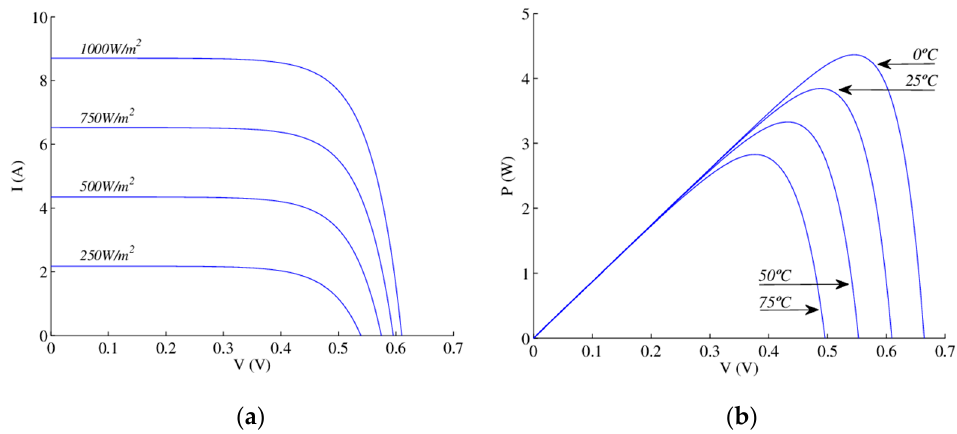
Figure 7. Simulation curves of I – V ( a ) and P – V ( b ) for PV power generation system. The model of the photovoltaic power generation system in PSCAD is shown in Figure 8: